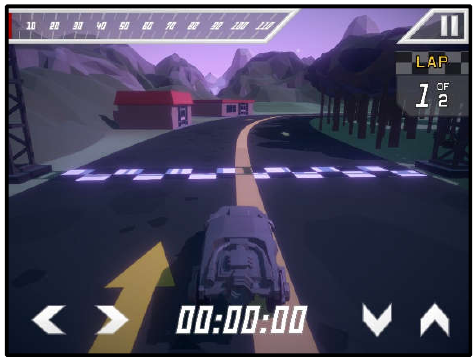
Figure 9. Race scene.